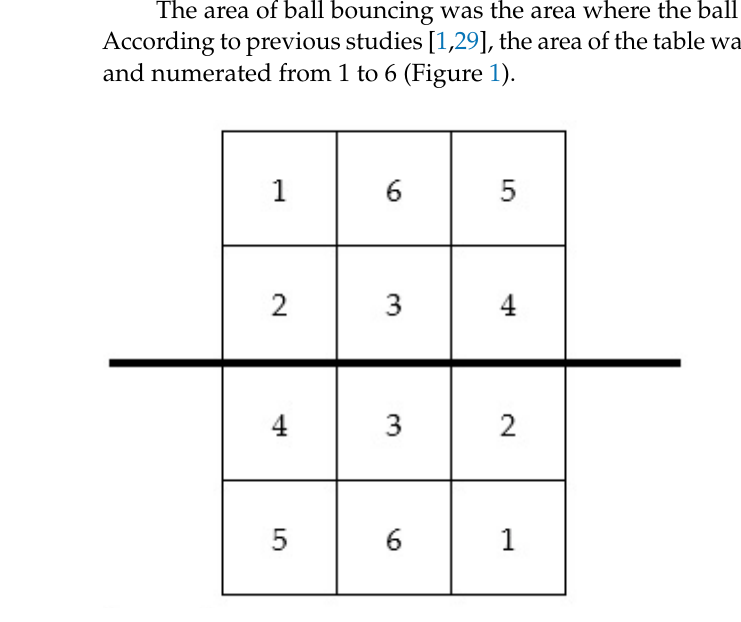
Figure 1. Six-area subdivision of each table tennis side. The thick line represents the net. The three categories of shots outcomes are presented in Table 2. Table 2. Description of shots outcome categories.